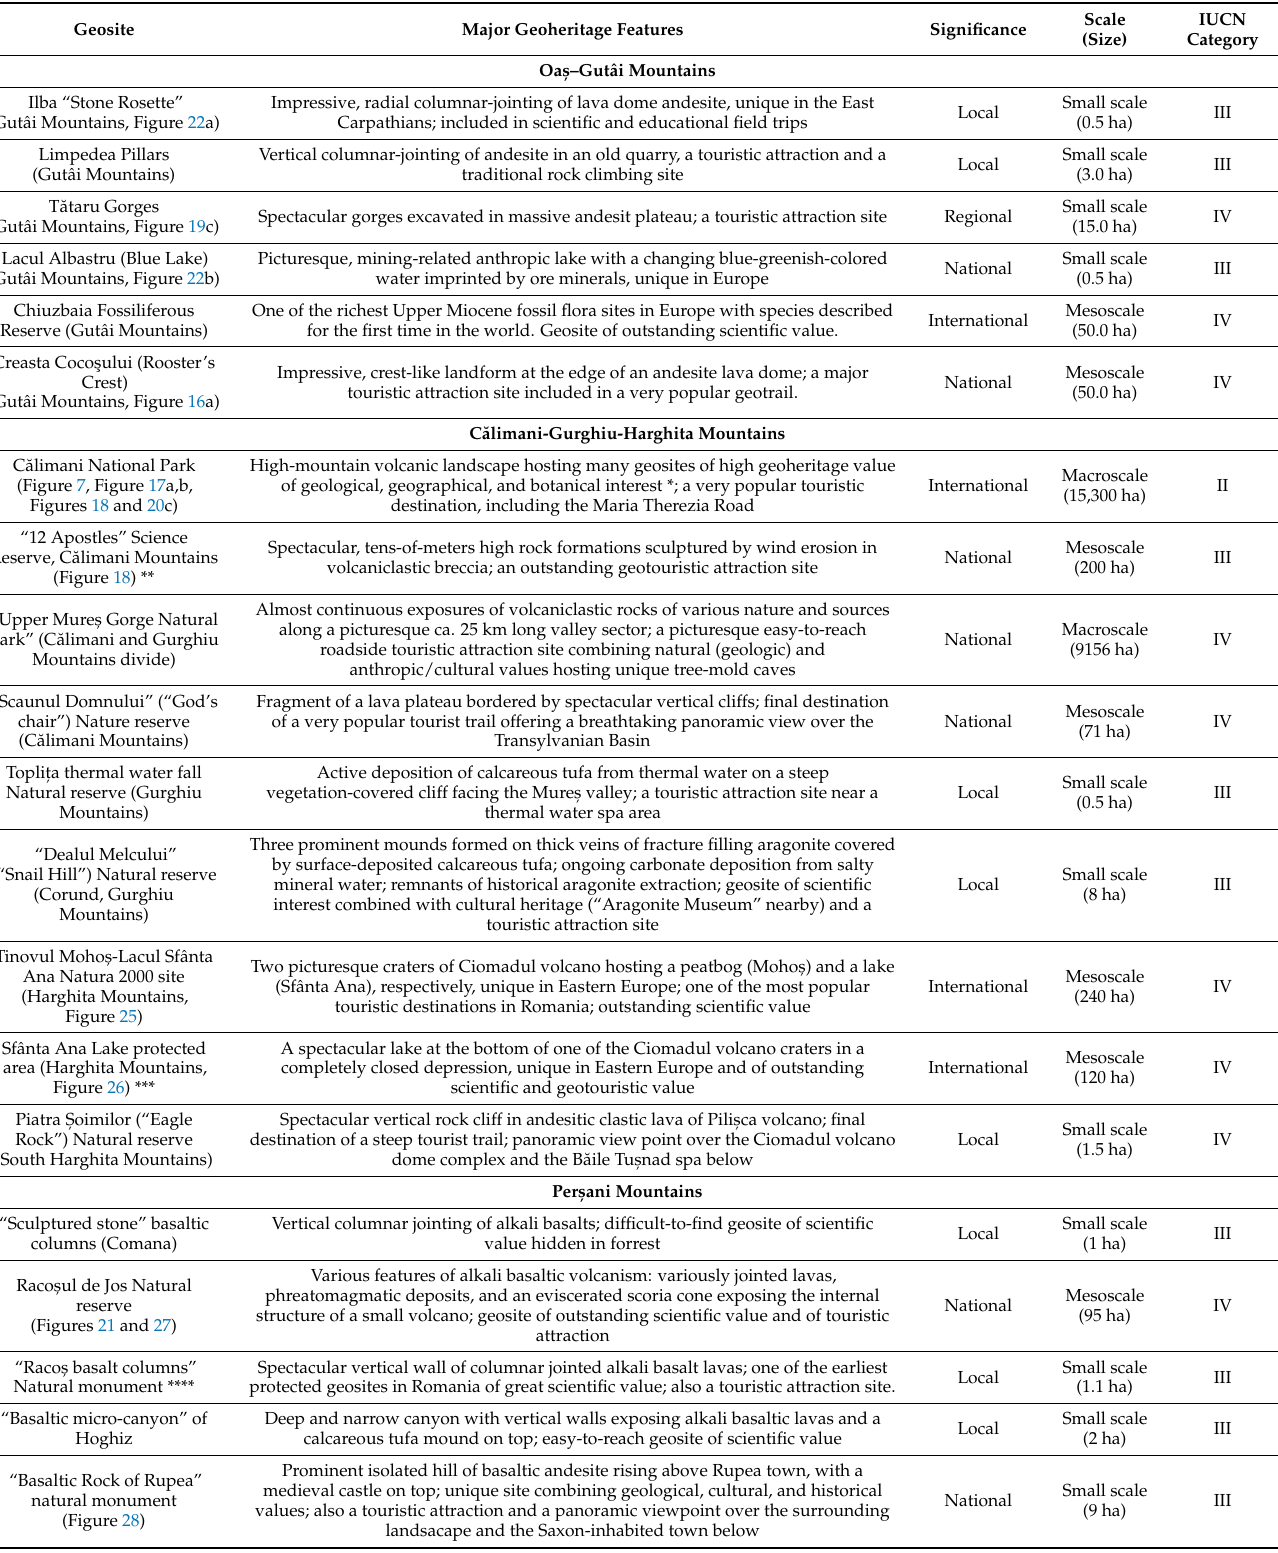
Table 3. Relevant features of geosites with official protection status in the East Carpathian volcanic area. (significance and scale categories acc. to [47].